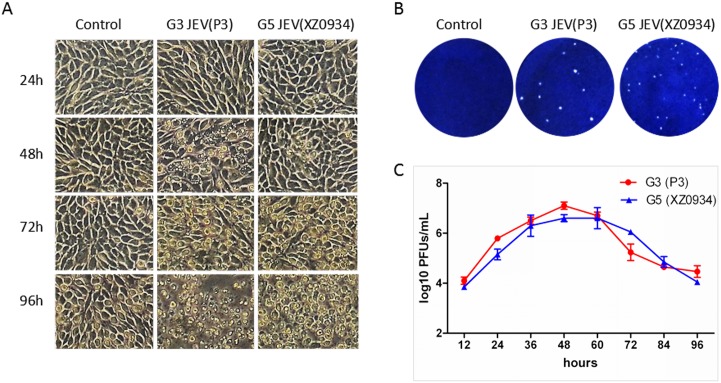
Phenotype comparison between G3 and G5 of JEV.(A) CPE of BHK-21 cells caused by P3 and XZ0934 strains at different times, included rounding, and cell rupture. (B) Plaque phenotype of the JEV P3 and XZ0934 strains in BHK-21 cells after 3 days of infection. (C) Relative multiplication characteristics of the P3 and XZ0934 strains in BHK-21 cells. Cells were plated into 6-well culture plates and infected with the JEV strains at a MOI of 0.01pfu /cell. Values represent the mean and standard deviation from three independent experiments.